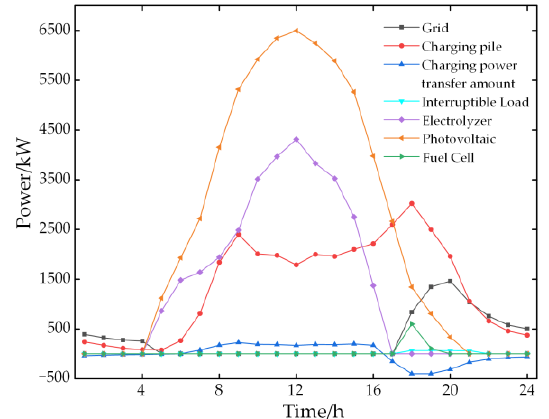
Figure 7. The power balance results of CES.